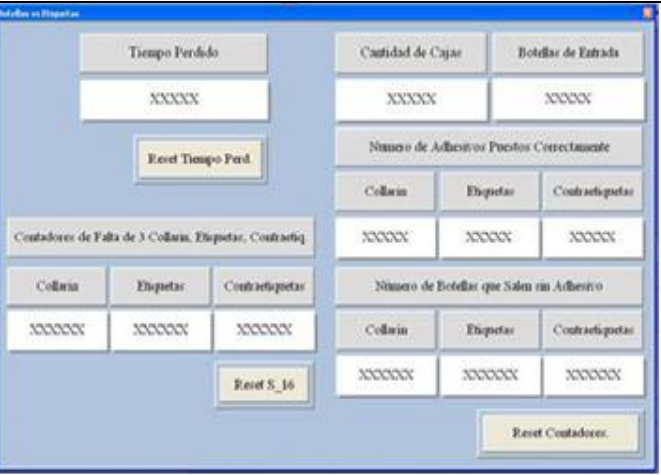
Figura 7: Pantalla de control de la materia prima y de la producción.